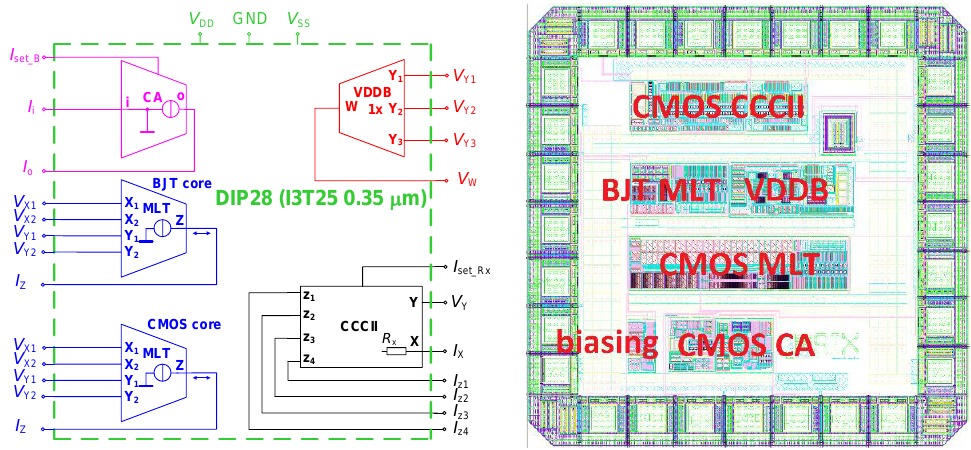
Figure 1. The fabricated IC: (left) contents on a cell level and (right) an illustration of the top layout design.